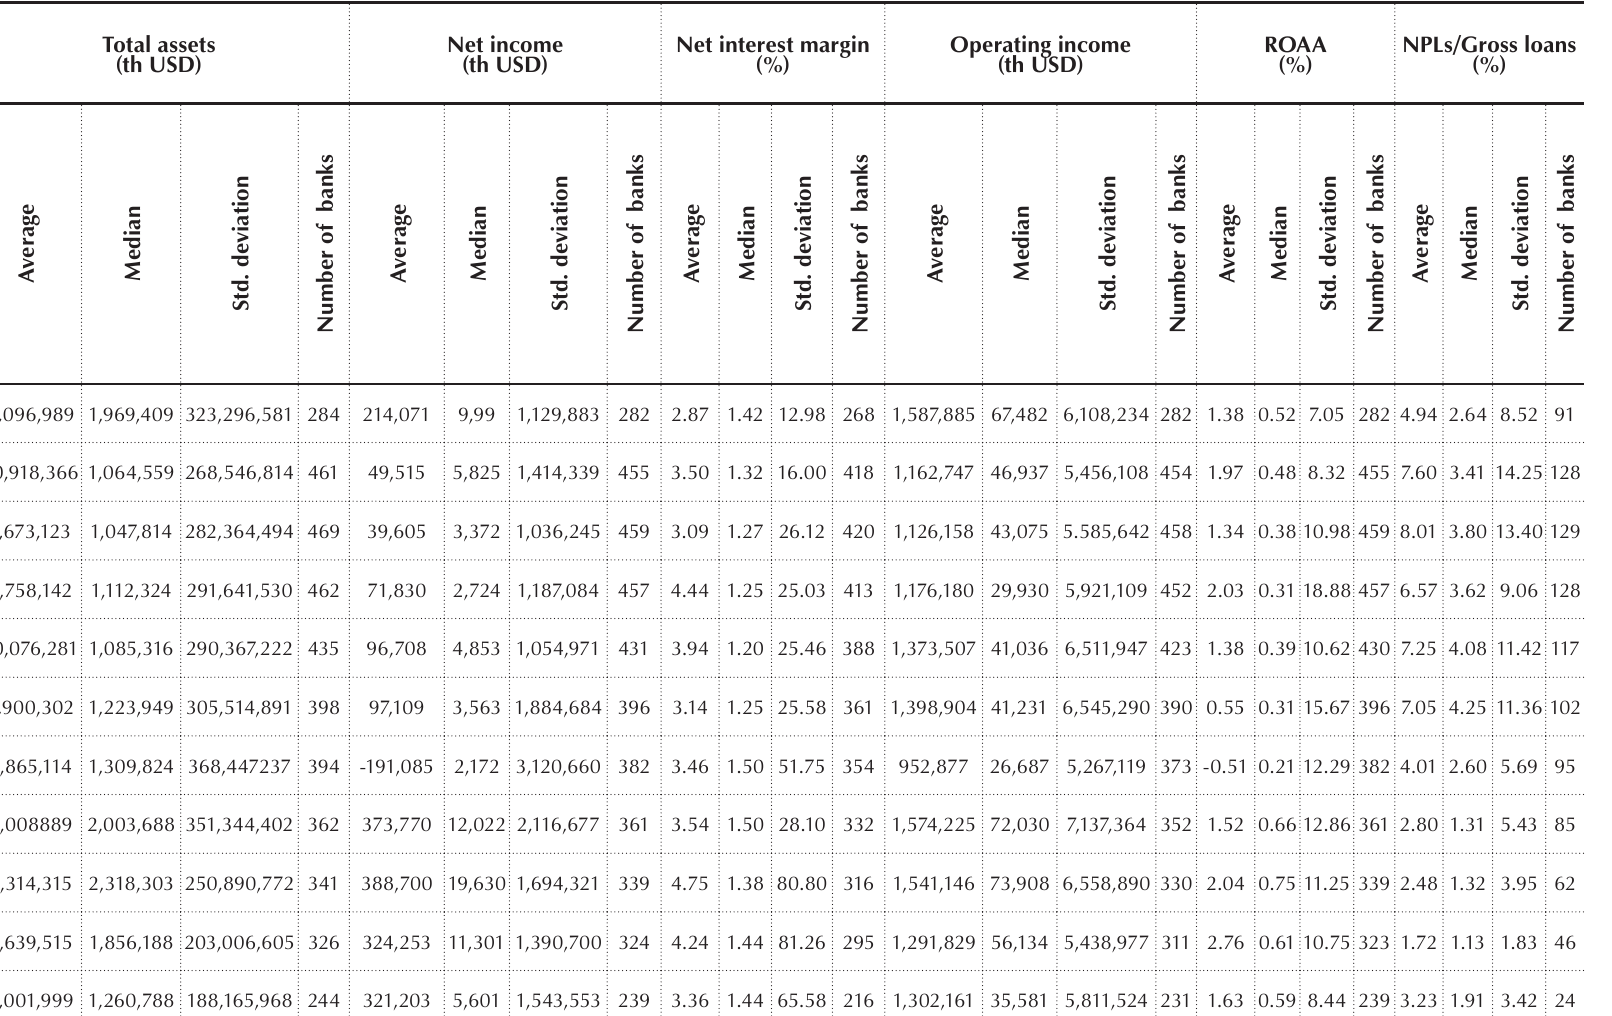
(cid:4)(cid:19)(cid:19)(cid:8)(cid:17)(cid:7)(cid:12)(cid:6)(cid:8)(cid:22) Appendix 1.